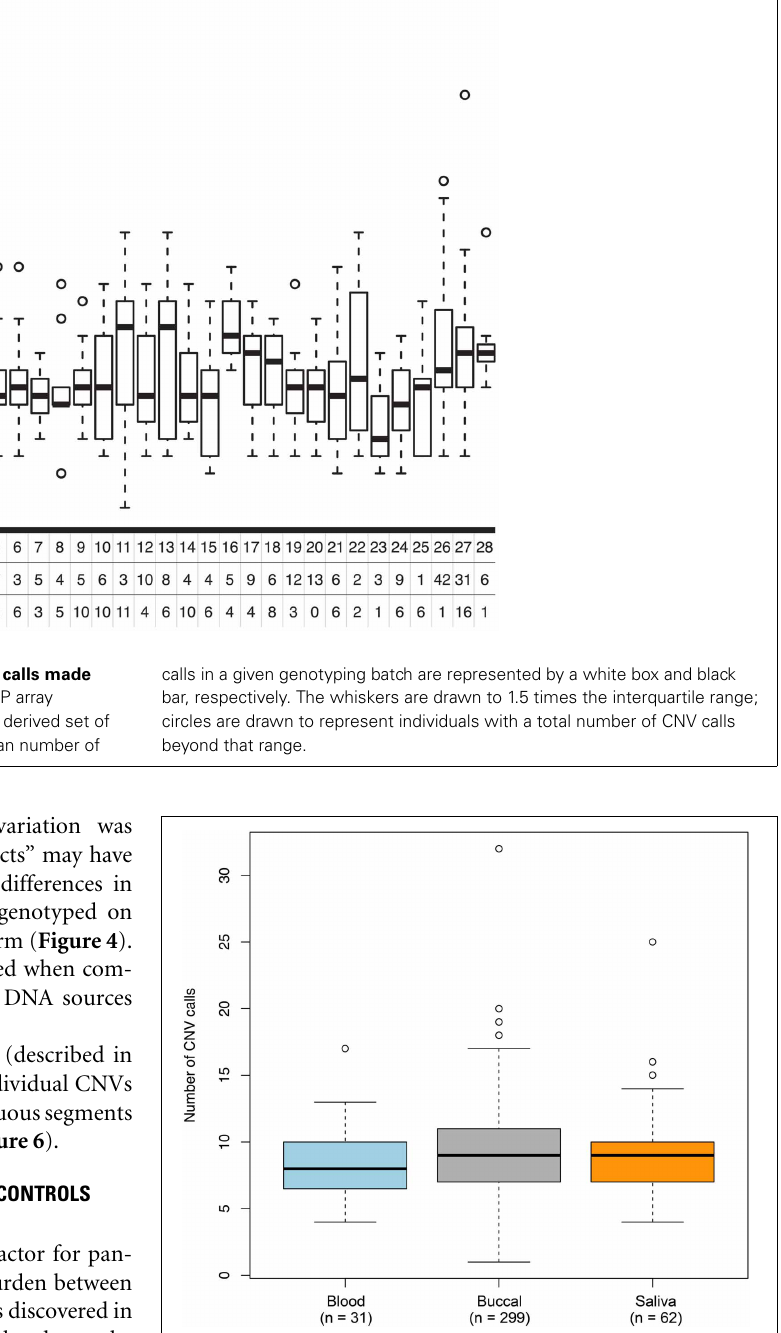
FIGURE 4 | Box-and-whisker plots of the number of CNV calls made across different DNA sources. Germline DNA was extracted from either a blood, buccal, or saliva biospecimen offered by each individual in our study. Based on the final set of 3520 QC-filtered CNV calls, the interquartile range and median number of calls derived from a given DNA source are represented by a shaded box and black bar, respectively. The whiskers are drawn to 1.5 times the interquartile range; circles are drawn to represent individuals with a total number of CNV calls beyond that range. We observed moderate (but non-statistically significant) variation in the number of CNVs detected between the DNA